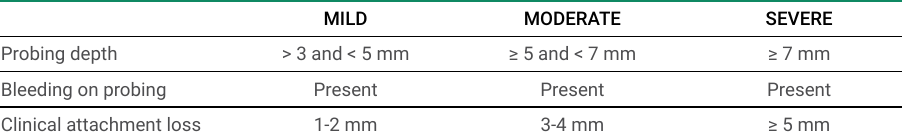
Table 1. Classification of severity based on the occurrence of at least one site with the following combinations of periodontal findings MILD MODERATE SEVERE Probing depth Bleeding on probing Present Present Present Clinical attachment